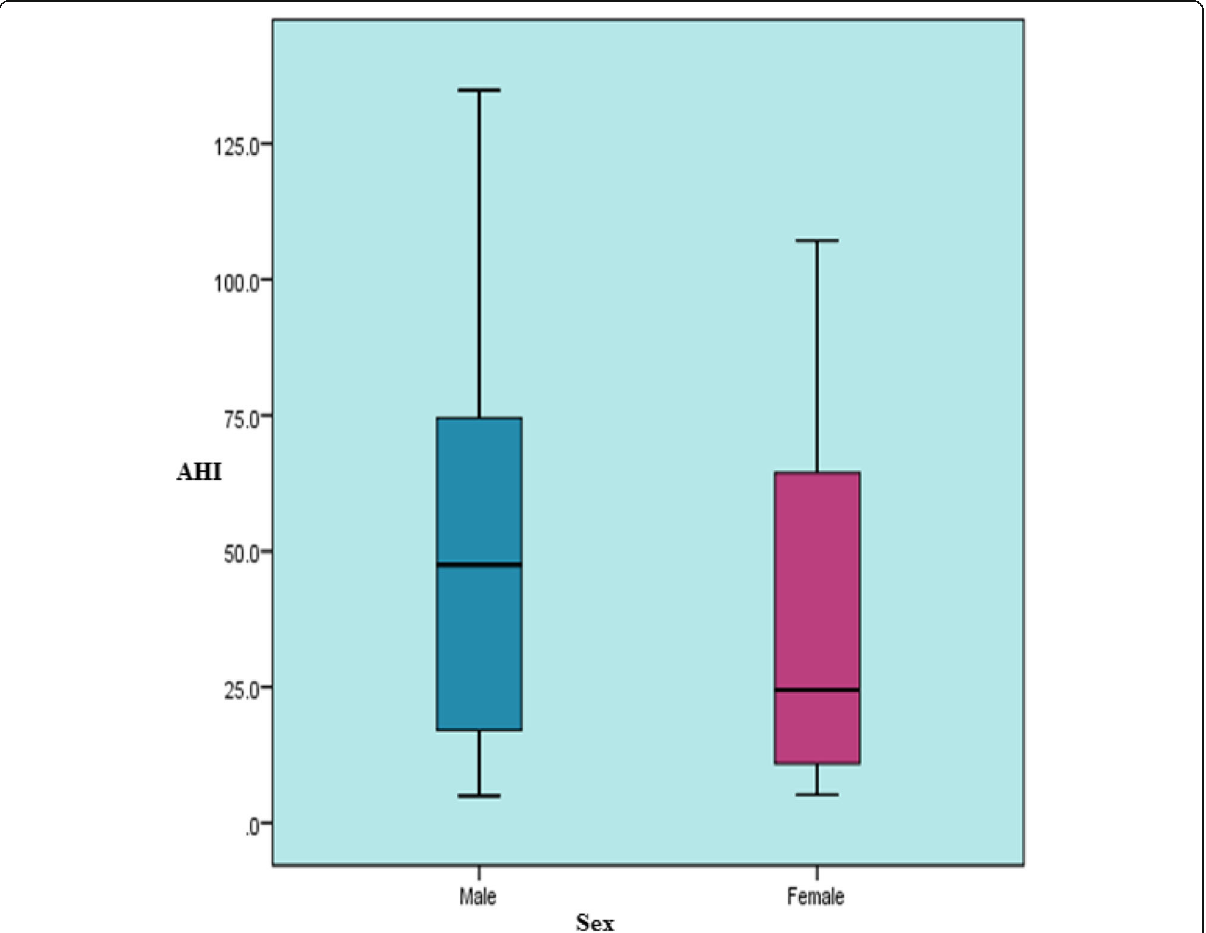
Fig. 1 Comparison of AHI severity between Egyptian men and